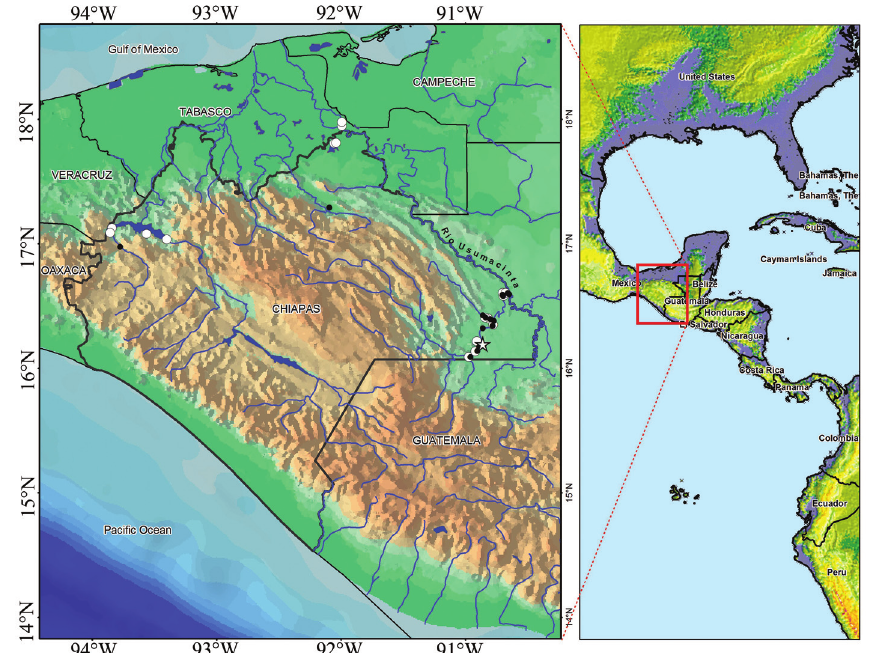
Fig. 4. Distribution of freshwater species of Eugerres in drainages along southeastern Mexico and northern Guatemala: E. castroaguirrei new species (black dots) and E. mexicanus (white dots), type locality